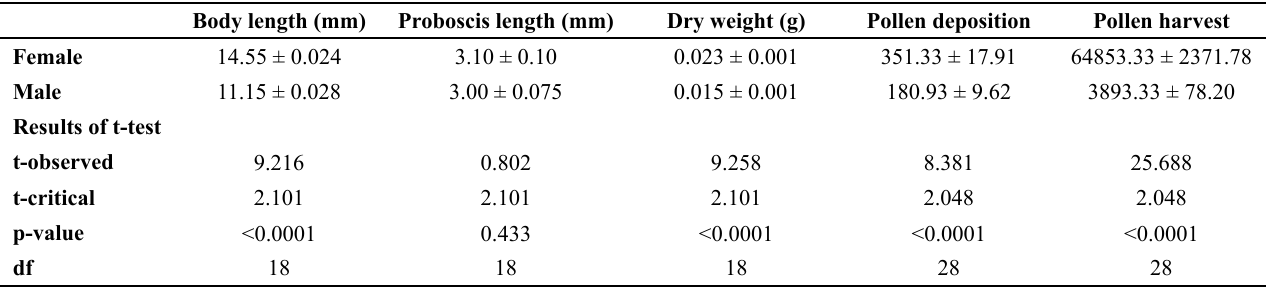
Table 2 . Comparison between female and male morphological features and pollination